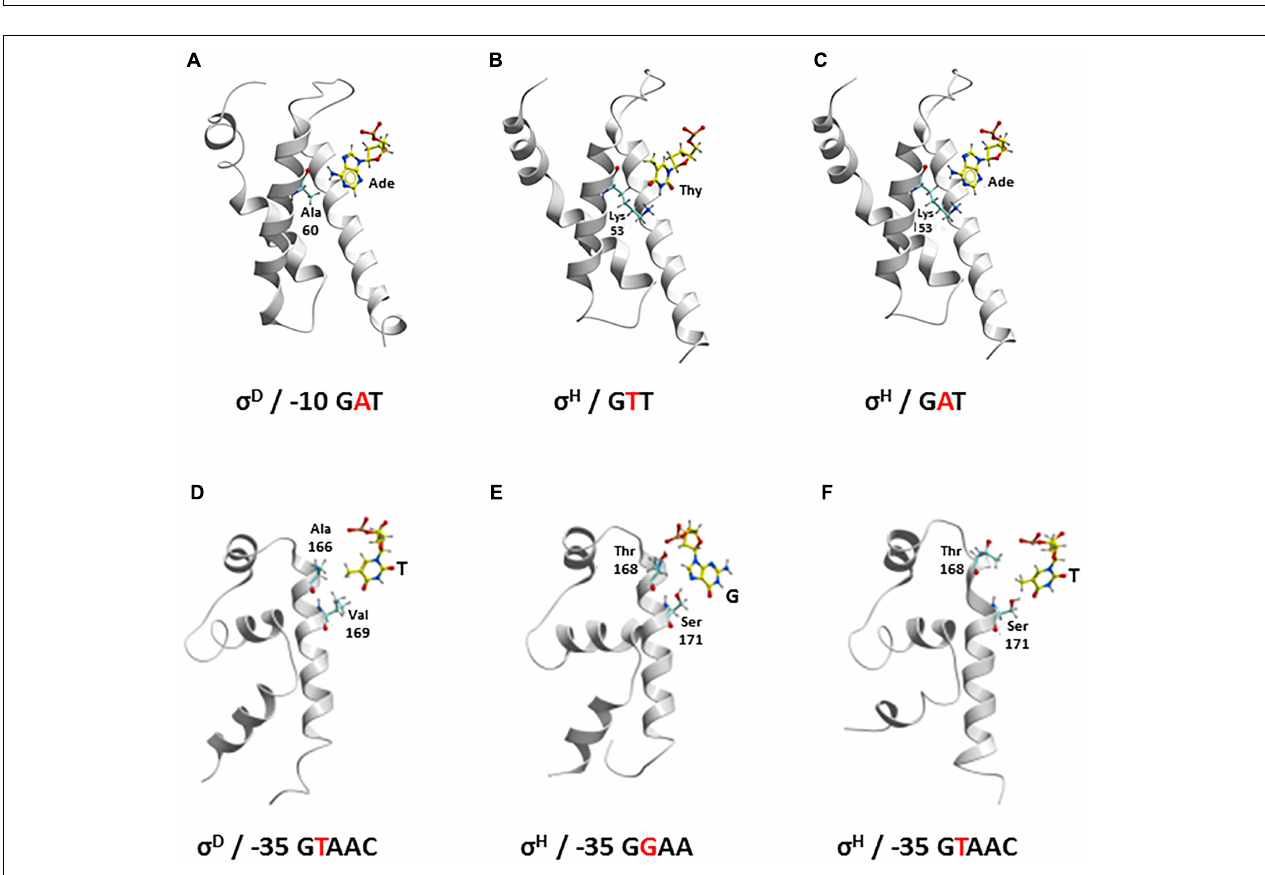
FIGURE 6 | Recognition of the nucleotide at second position of –10 element (yellow represents carbon; red, oxygen; blue, nitrogen; white, hydrogen, Ade, adenine; Thy, thymine) (A–C) by Ala 60 in σ D and Lys 53 in σ H (cyan, carbon) and at second position of –35 element (yellow, carbon) (D–F) by Ala 166 and Val 169 in σ D and Thr 168 and Ser 171 in σ H (cyan, carbon). –10: (A) σ D and σ D -dependent promoter; (B) σ H and σ H -dependent promoter; (C) σ H and σ D -dependent promoter